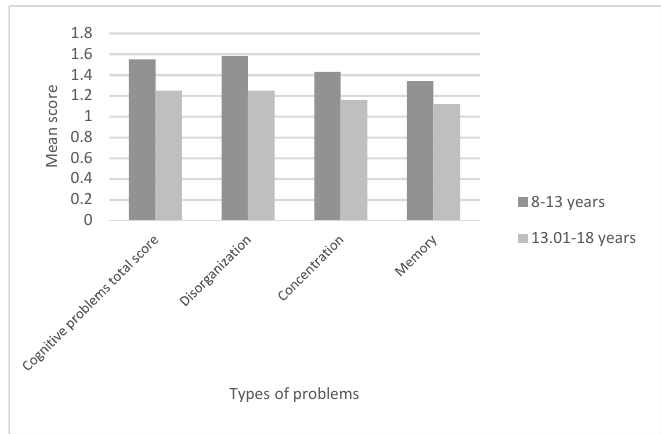
Figure 1. Cognitive problems (reported) according to patients’ age band.